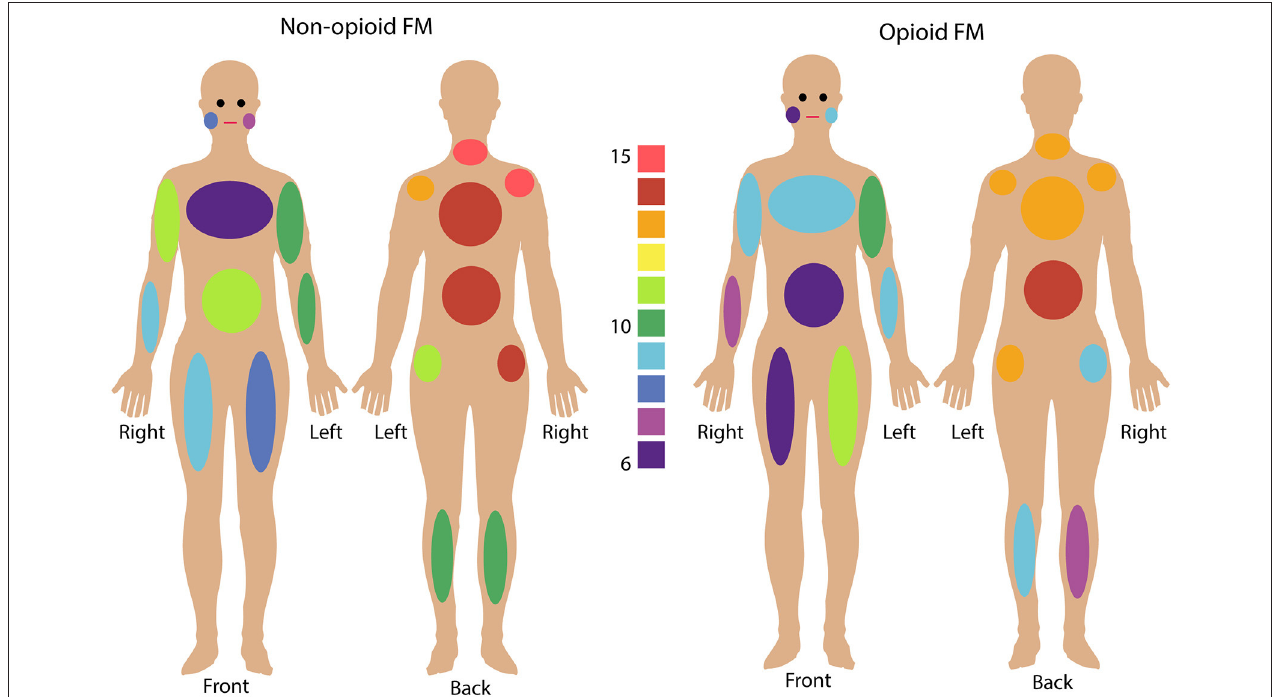
FIGURE 1 | Fibromyalgia pain distribution across the body. Non-opioid patients (left) and opioid patients (right) are shown. Colors indicate the number of patients in each group who reported pain in any given body area using the Fibromyalgia Assessment Questionnaire. Bilateral body areas include right and left shoulder, upper arm, lower arm, hip, upper leg, lower leg, and jaw; and axial areas include chest, abdomen, upper back, lower back, and neck. (See Supplementary Table 5 for details on individual patient reported pain